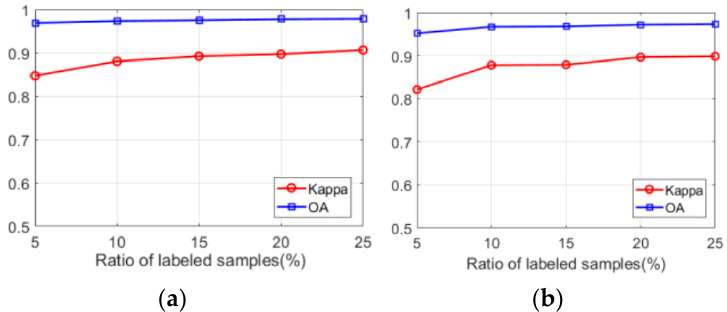
Figure 17. Kappa and OA with different labeled ratios. ( a ) Sample 1. ( b ) Sample